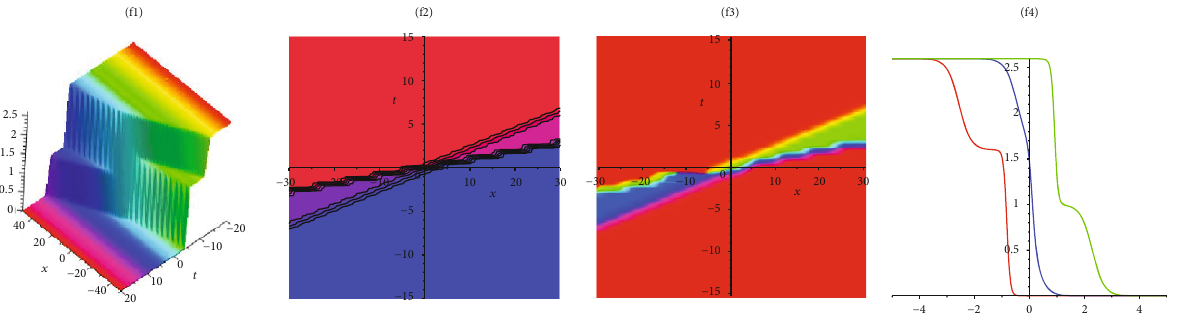
= 1, α = 1 : 6, σ = 1 : 5, ρ = 1 : 5, ρ 1 2 2